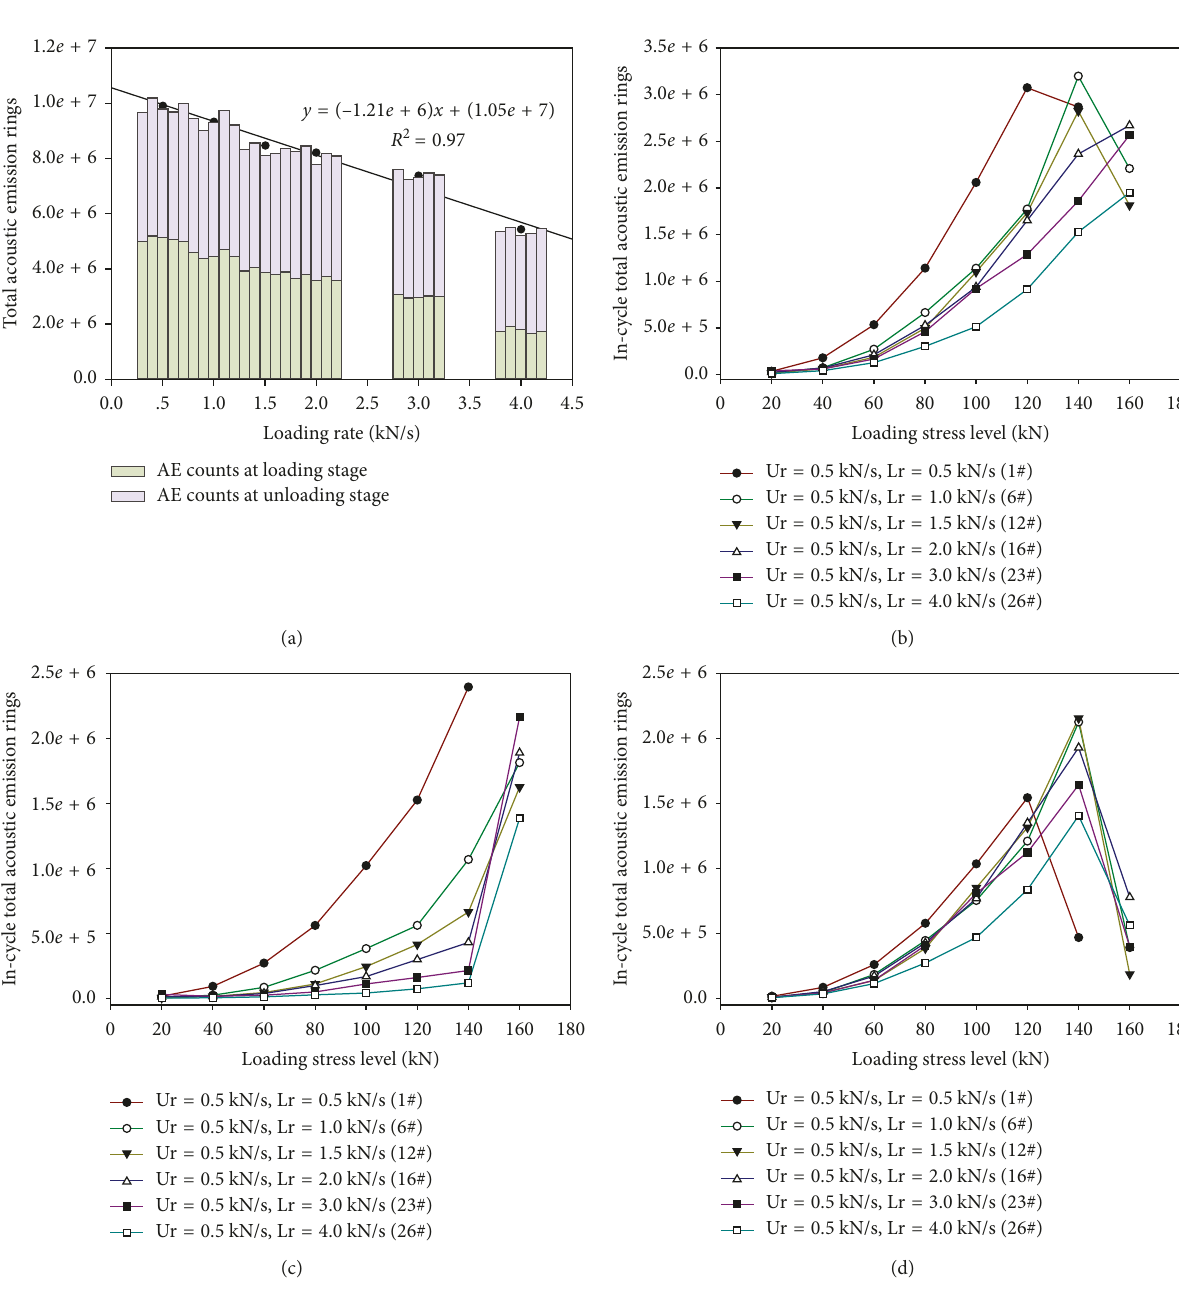
Figure 7: Variation of the AE characteristics of red sandstone specimens (Ur loading rates; (b) total AE rings of each cycle versus loading stress levels; (c) total AE rings at the loading stage of each cycle versus loading stress levels; (d) total AE rings at the unloading stage of each cycle versus loading stress